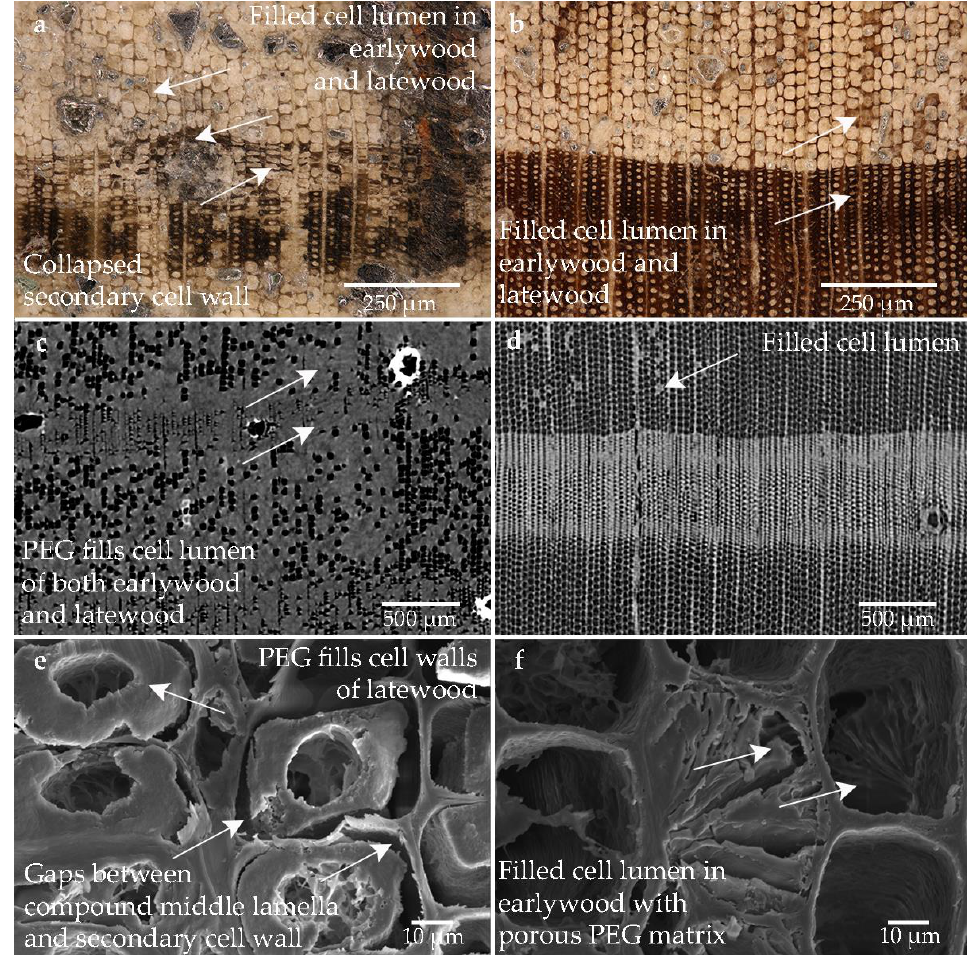
Figure 7. Microscopic wood structure of sample conserved with PEG 400 and PEG 4000 and freeze- drying (Pi1-PEG2) ( a ) RLM image from the heavily degraded area; ( b ) RLM image from the low degraded area; ( c ) CT image of the cross section of the heavily degraded sample; ( d ) CT image of the cross section of the low degraded sample; ( e ) SEM image of the latewood tracheids; ( f ) SEM image of the earlywood tracheids in the heavily degraded area.